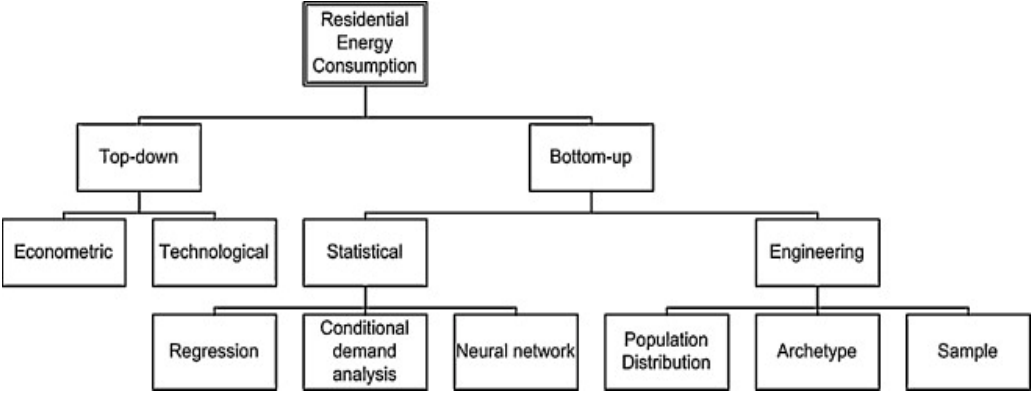
Figure 3. Modeling techniques to estimate the residential energy consumption. Reprint with permission [14]; Copyright 2009, Elsevier.